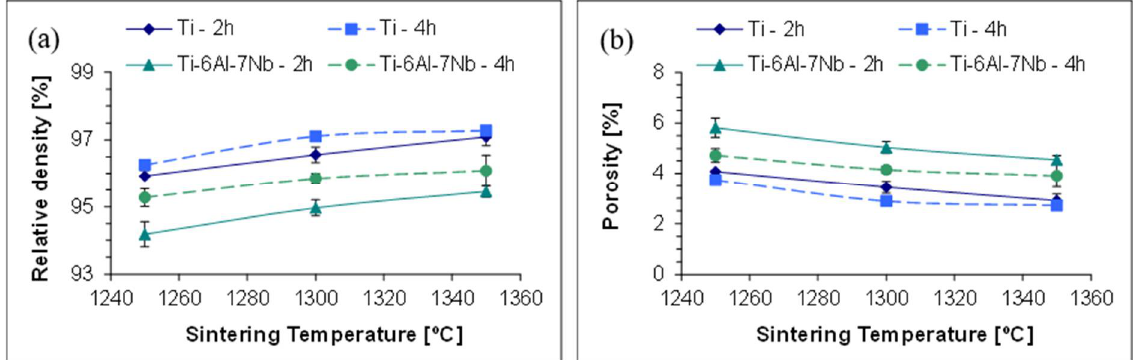
Figure 1. Variation of the relative density ( a ) and porosity ( b ) of the P/M Ti and Ti-6Al-7Nb alloy with the sintering temperature for different dwell times.